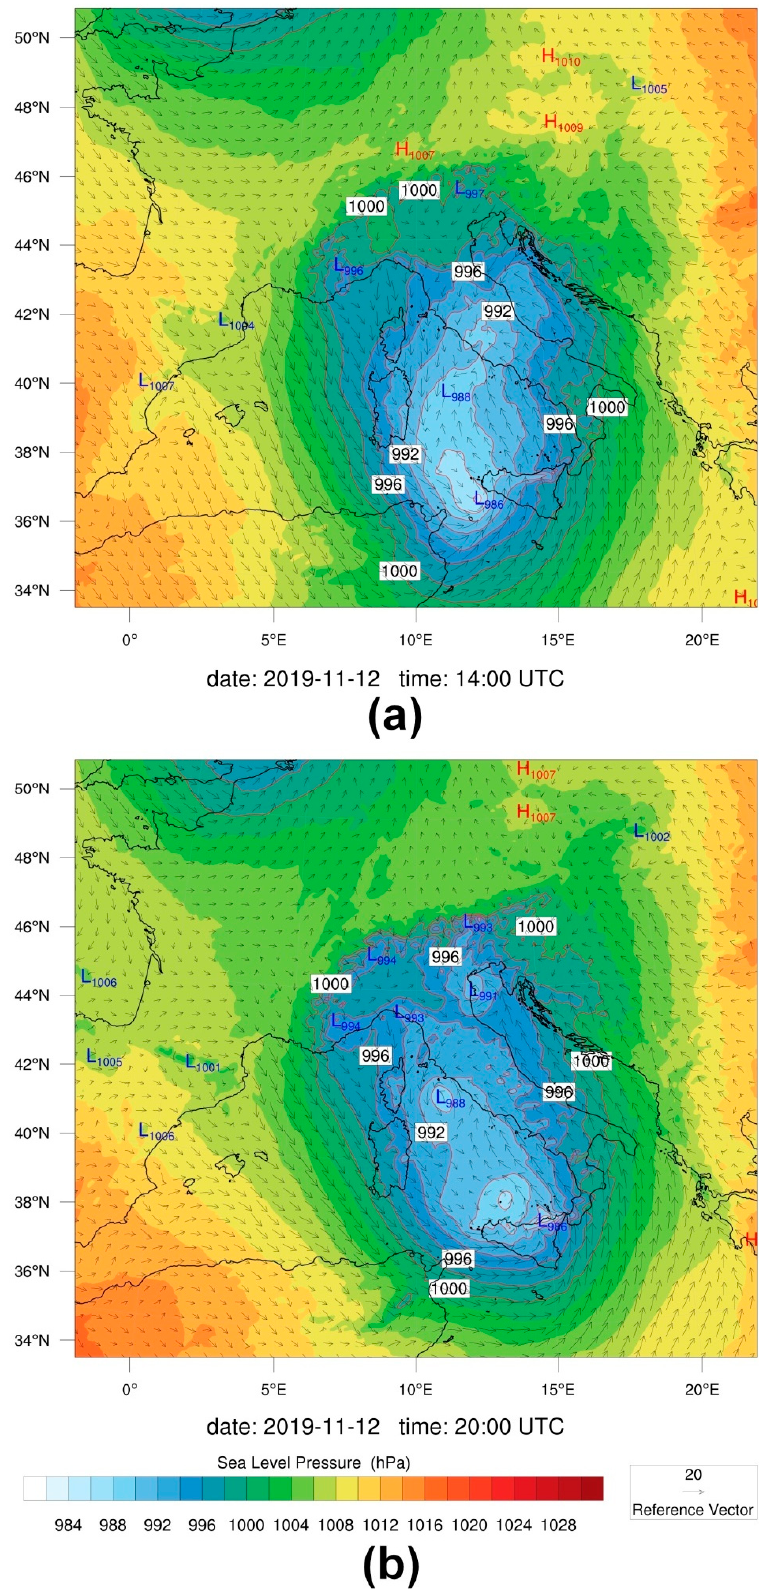
Figure 8. Mean sea level pressure (colored scale and red lines, in hPa) and surface wind vectors (m s − 1 ) at 14:00 UTC, 12 November 2019 (panel ( a )) and at 20:00 UTC, 12 November 2019 (panel ( b )). Run with data assimilation until 22:00 UTC,outer grid.